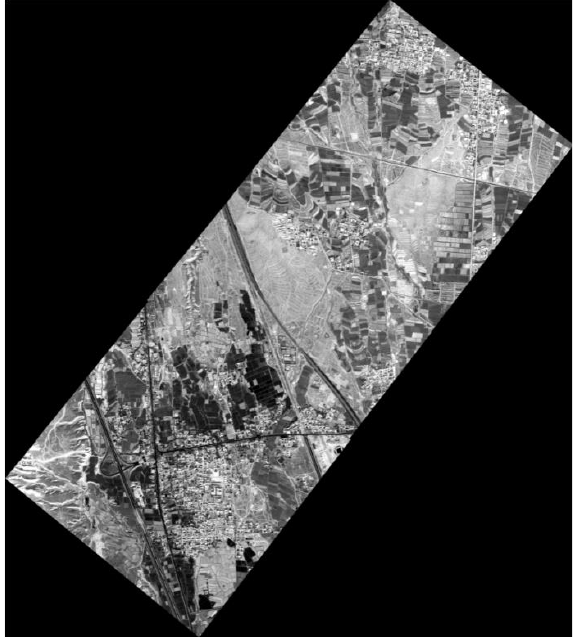
Figure 7. Stitched image in stable flight condition.